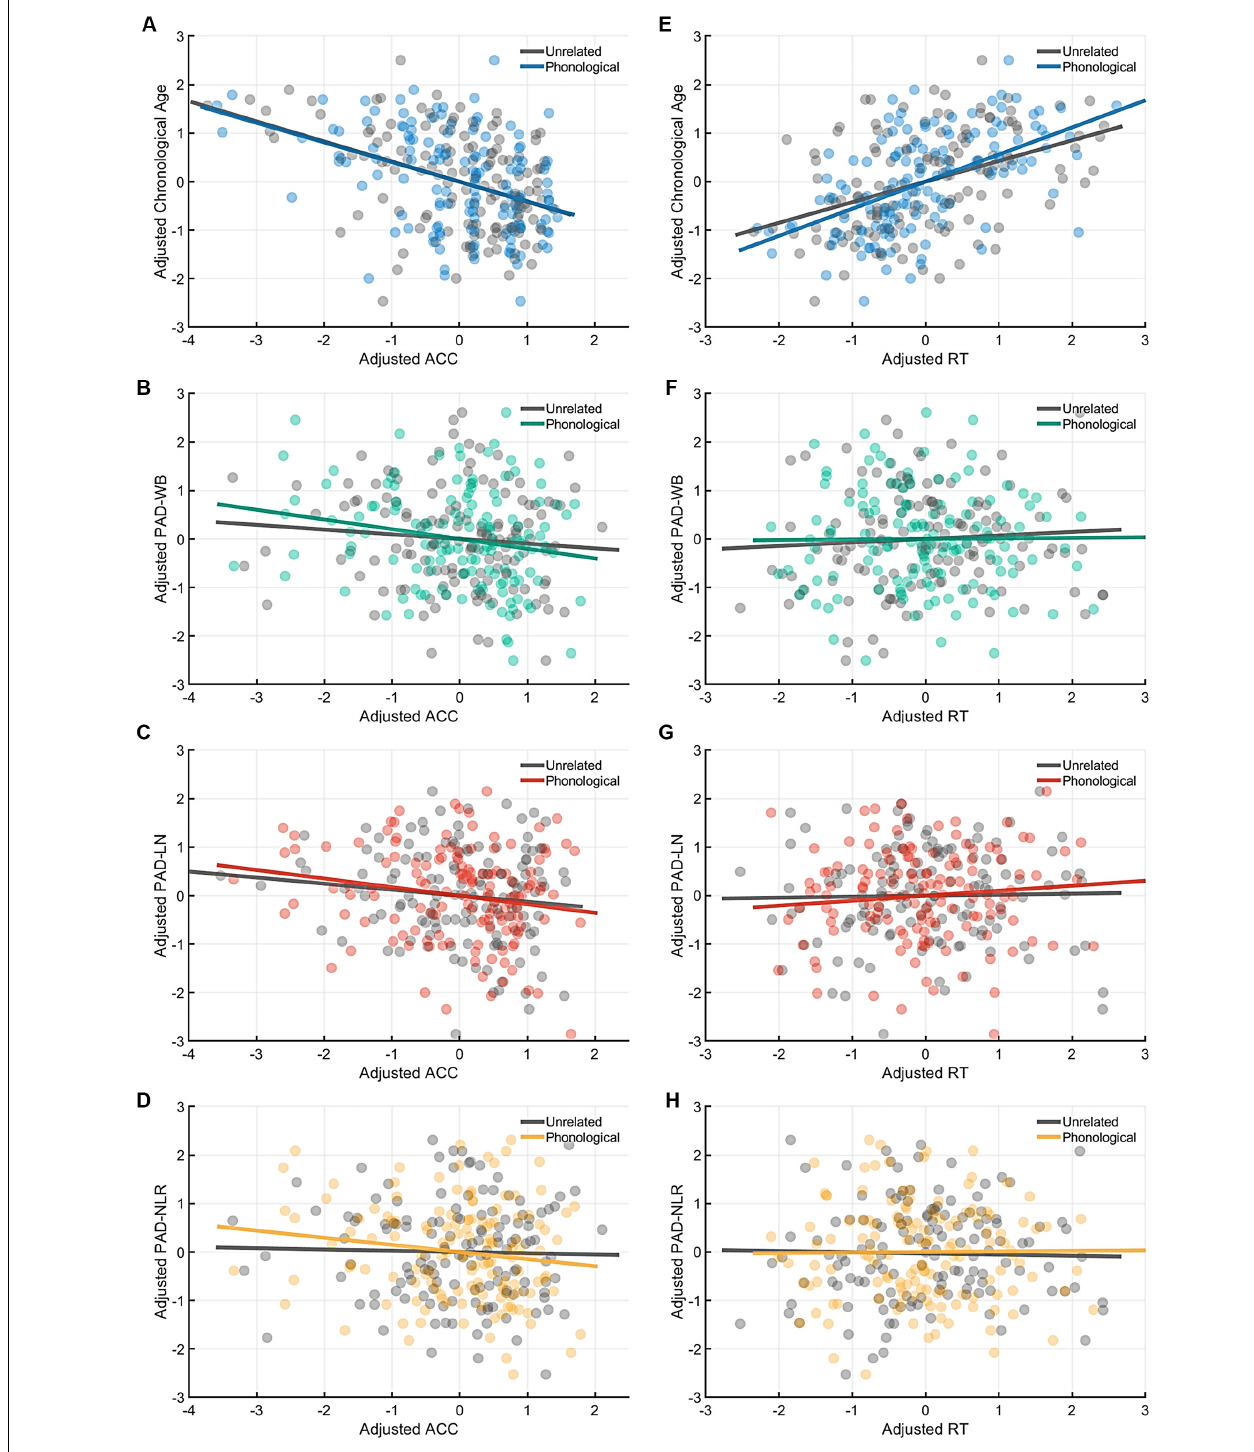
FIGURE 4 | Partial correlation of the cognitive indices (ACC and RT) at the phonological-priming condition with age measures (chronological age and brain age). Under the phonological-related priming condition, chronological age was significantly correlated with ACC (A) , and the PAD-WB and PAD-LN were marginally associated with ACC. (B–C) However, the PAD-NLR was not associated with ACC. (D) On the other hand, only chronological age was significantly correlated with RT (E) , whereas all brain age measures were not correlated with RT (F–H) . Abbreviation: ACC, accuracy; RT, response time; PAD, predicted age difference; NLR, non-language regions; LN, language network; WB, whole